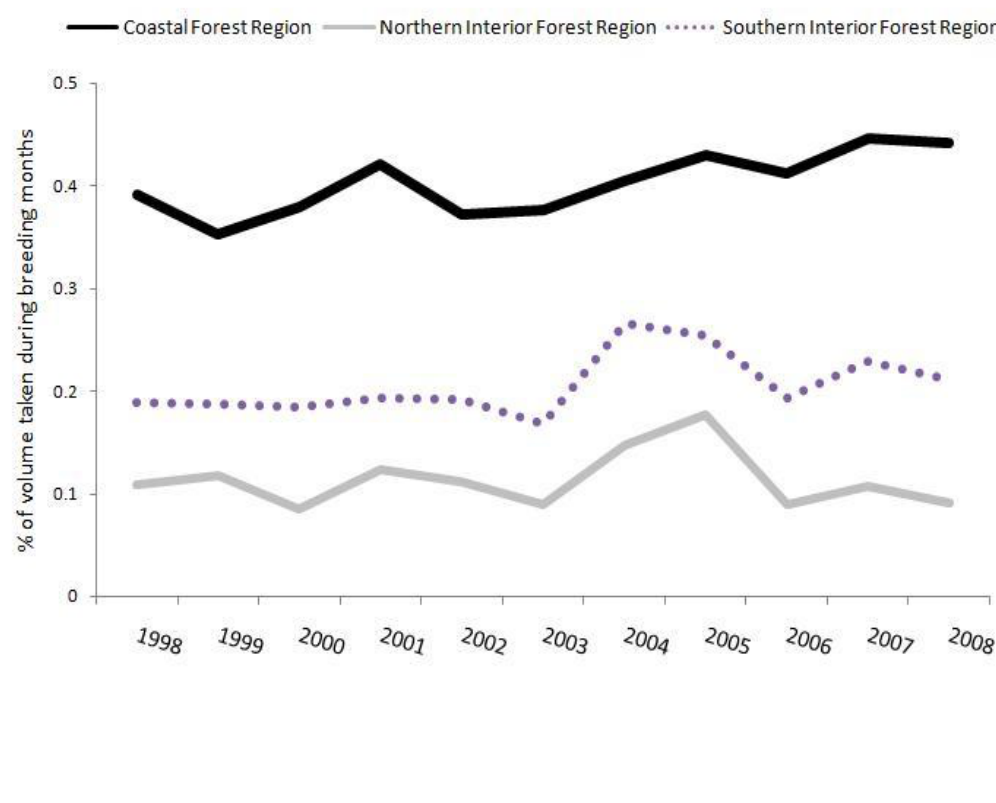
Figure A2.1 . Annual variation in the percentage of the timber volume harvested during active breeding periods across the Coastal (CFR), Northern Interior (NIFR) and Southern Interior (SIFR) Forest Districts averaged across 1998-2008. Data obtained from the BC Ministry of Forestry’s Harvest Billing System ( HBS ),